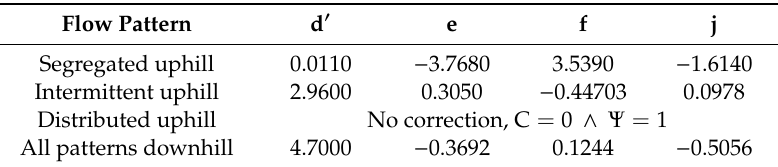
Table 4. Parameters for holdup correcting factor